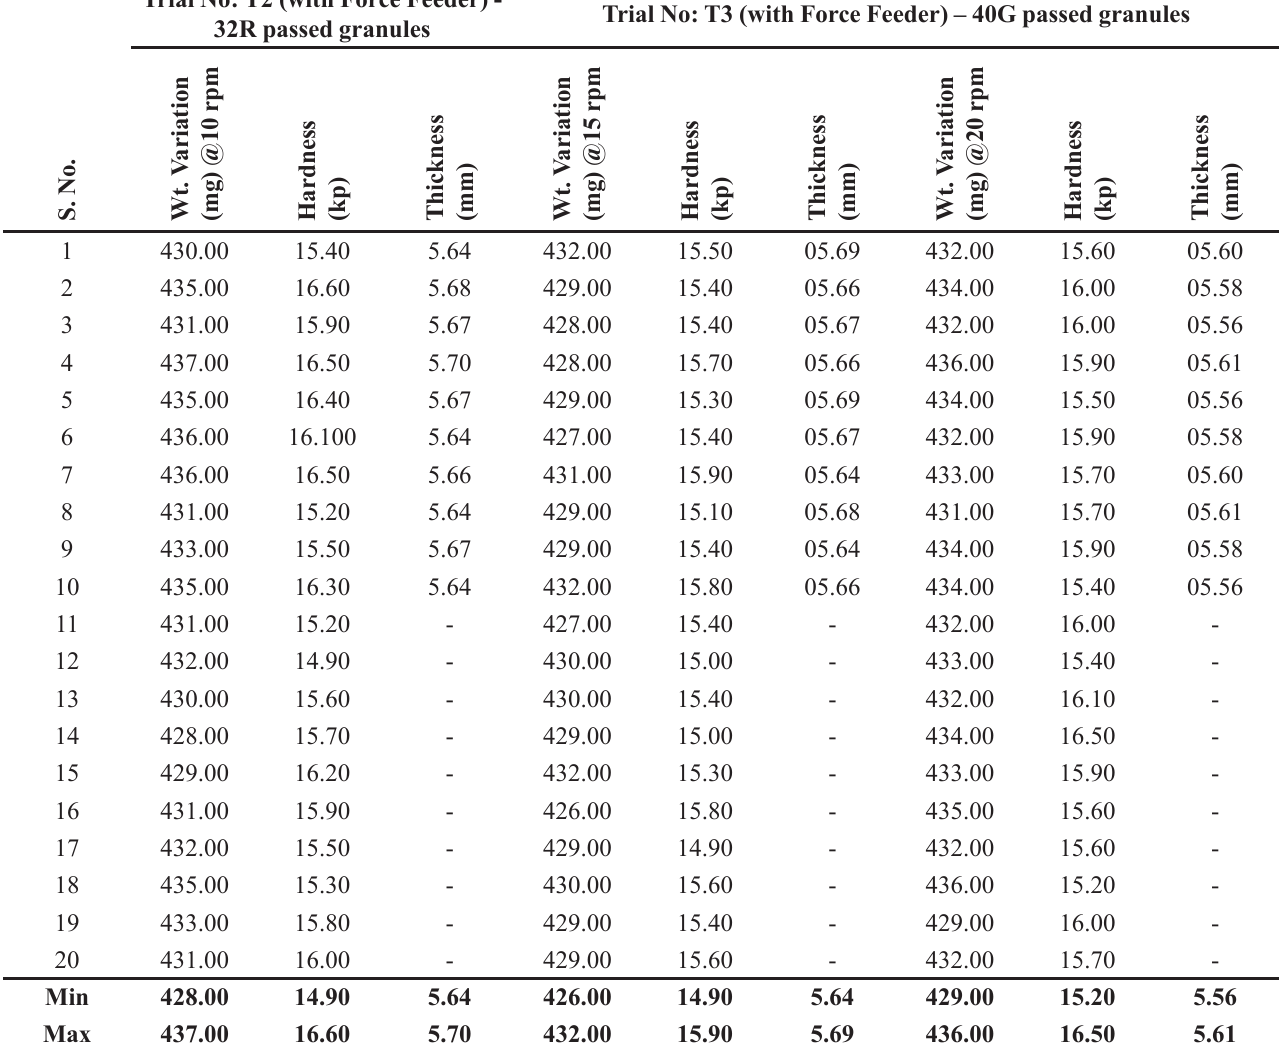
TABLE VI - Compression data for trial no T2 and T3 (using force feeder) of 32R & 40G screen milled granules. Trial No: T2 (with Force Feeder)